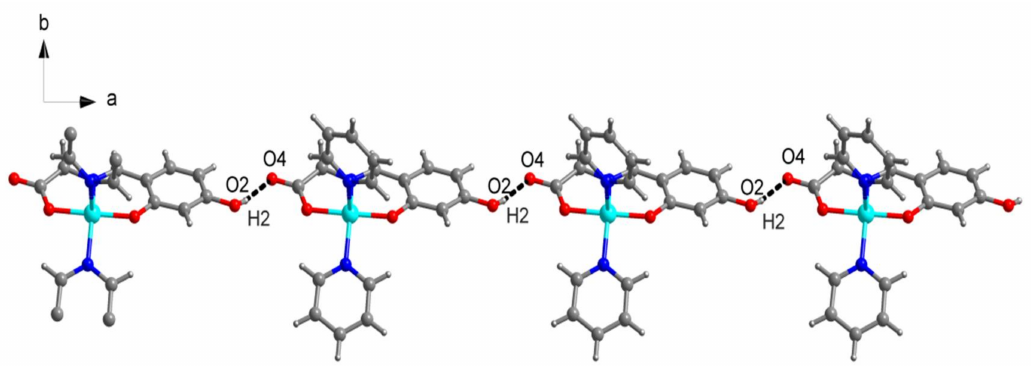
Figure 6. A representation of the one-dimensional chains of Complex 2 via the a–b plane.